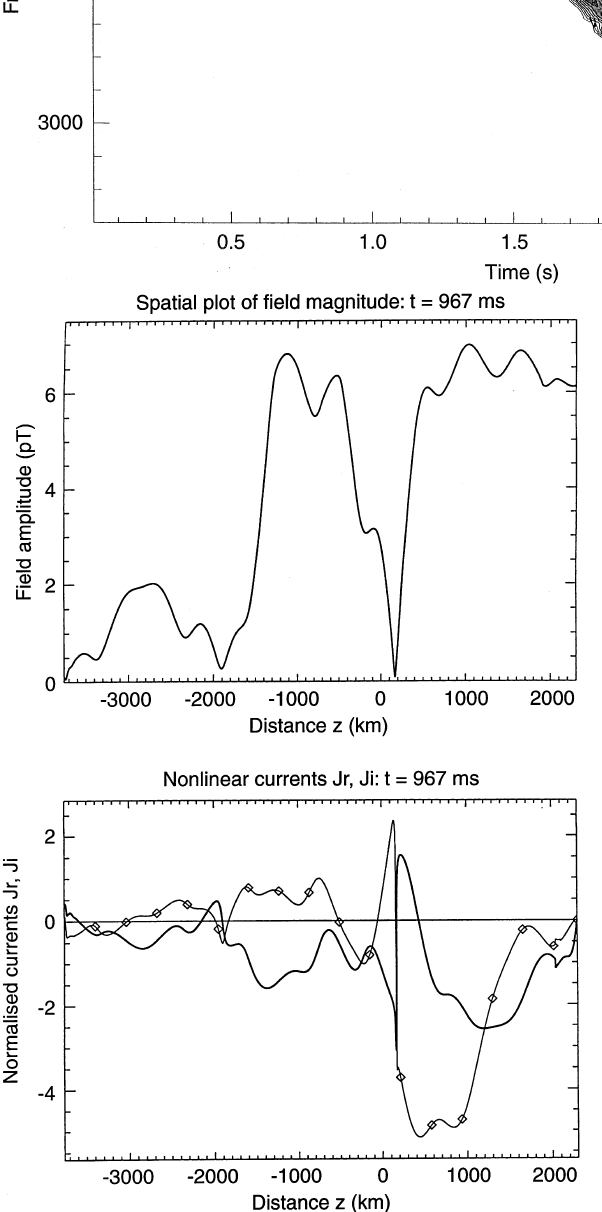
Fig. 10. Case B. Steep faller. Frequency time diagram of the exit wave field. The sweep rate is about ) 1 kHz/s. The emission terminates at t = 2.2 s due to the decreasing linear growth rates at lower frequencies